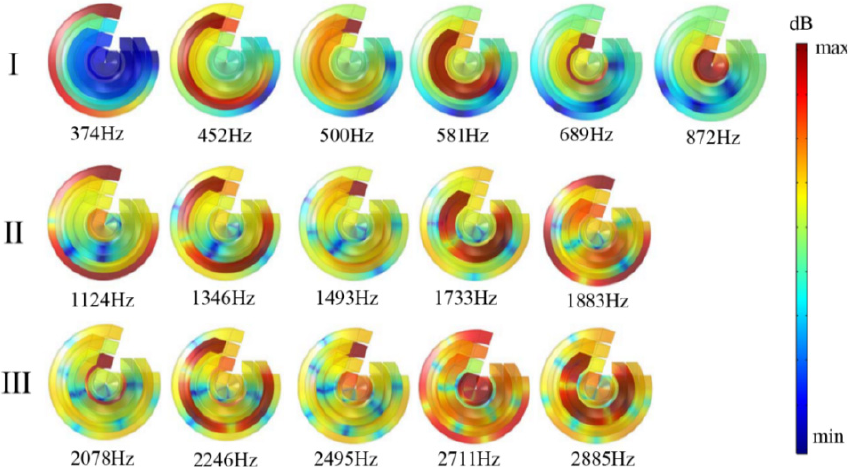
Figure 5. Distributions of the sound pressure level (SPL) of MSC-AM within resonance frequency points in simulation.